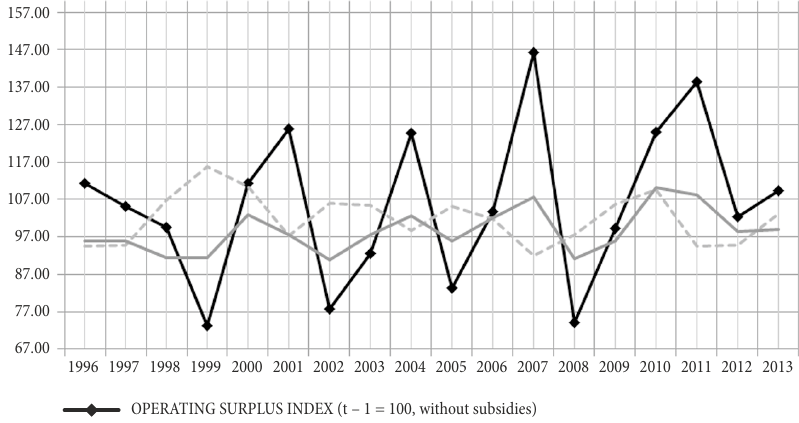
Fig. 1. Surplus rate in agriculture in Poland and its macroeconomic determinants Note: *The PRICE GAP INDEX is the ratio between the price index of products sold by individual farms and the price index of goods and services purchased at private farms in Poland (the inflation rate is